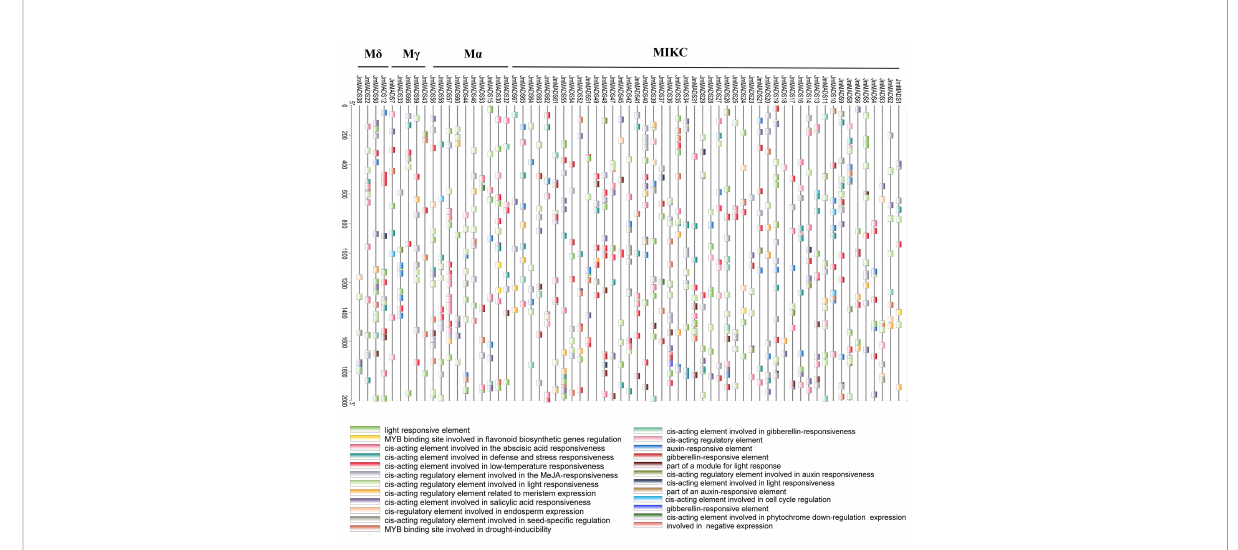
FIGURE 5 Analysis of cis-acting elements of MADS-box genes. JmMADS1 ~ JmMADS67 represent 67 genes in J. mandshurica ; M d , M g , M a , MIKC represent the four subfamilies. Boxes with different colors at the bottom represent the cis-acting elements.